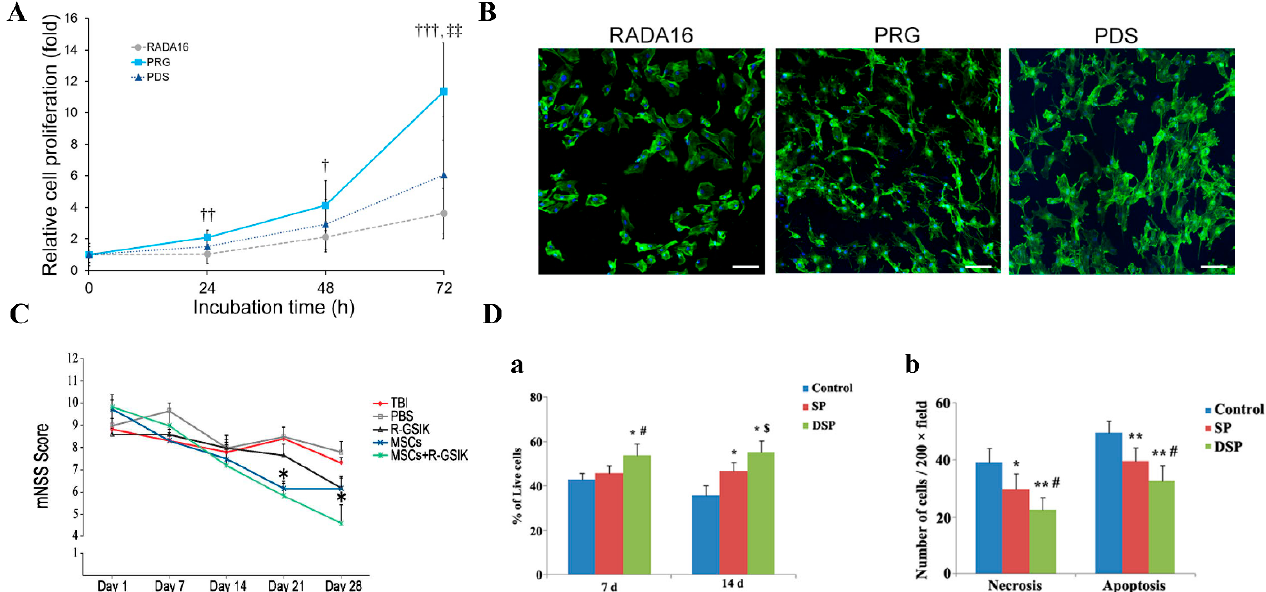
Figure 3. Motifs from the extracellular matrix. ( A ) Viability/proliferation of rat periodontal ligament- derived cells (rPDLCs). rPDLCs were cultured on the RADA16, PRG (RADA16-PRG), or PDS with medium or medium alone (control). WST-1 assay was used to assess cell viability/proliferation at indicated time points. In each group, values relative to those at 0 h were shown. Data presented as mean ± SD ( n = 7). † p < 0.05, †† p < 0.01, ††† p < 0.001 compared with the RADA16 group, and ‡‡ p < 0.01 compared with the PDS group, by ANOVA with Tukey’s post hoc test. ( B ) Representative con- focal laser scanning microscopy images. At 72 h, cells on PRG or PDS appear elongated and show cell protrusions. (Green; actin cytoskeleton). (Original magnification ×100, bar = 100 µm). Adapted with permission from Ref. [52]. Copyright 2021 Journal of Periodontal Research. ( C ) Modified neu- rological severity scores (mNSS) were performed in different groups. mNSS significantly improved in rats treated with MSCs+ R-GSIK and MSCs compared with TBI and PBS groups on day 21 after TBI. Adapted with permission from Ref. [53]. Copyright 2020 Cell and Tissue Research. ( D ) RADA16-YIGSR (DSP) increased the cell viability and protected NSC against the cytotoxicity of aggregated A β . ( a ) Cell viability was detected at 7 and 14 days after being seeded in DSP. NSCs in modified peptides showed increased cell survival compared to the unmodified RADA16 (SP). * p < 0.01 versus control; # p < 0.01 and $ p < 0.05 versus SP. ( b ) Cell survival after A β 1–40 treatment. * p < 0.05 and ** p < 0.01 versus control; # p < 0.05 versus SP. Adapted with permission from Ref. [54]. Copyright 2016 Molecular Neurobiology.